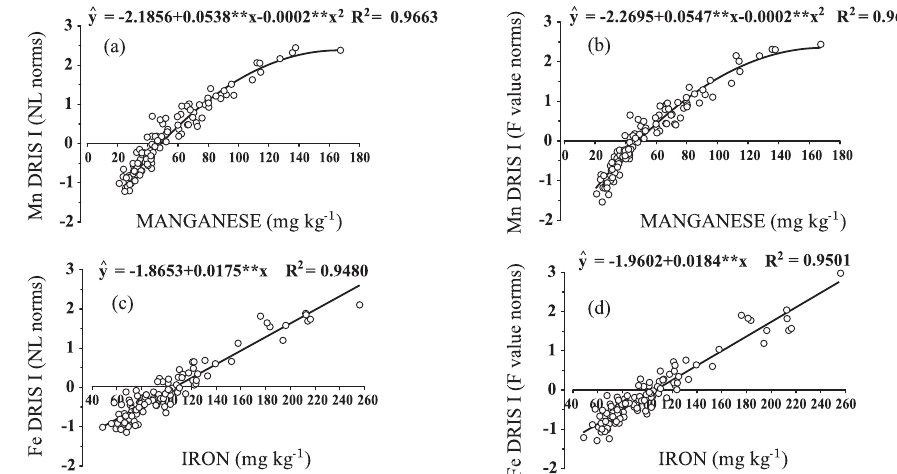
figure 4. Ratio between the levels of micronutrients (reference and non-reference population), manga- nese (Mn) and iron (fe) and their respective DRis indices (DRis i), generated by the norms based on the criterion of natural log transformation (nl) (a and c) and the norms defined by f value (b and d). ** p <